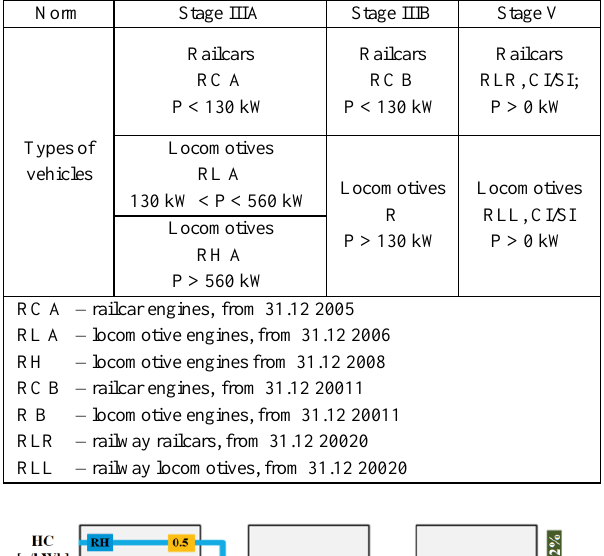
Table 2 . Railway vehicle engine categories in stages: IIIA, IIIB and V [4, 18]